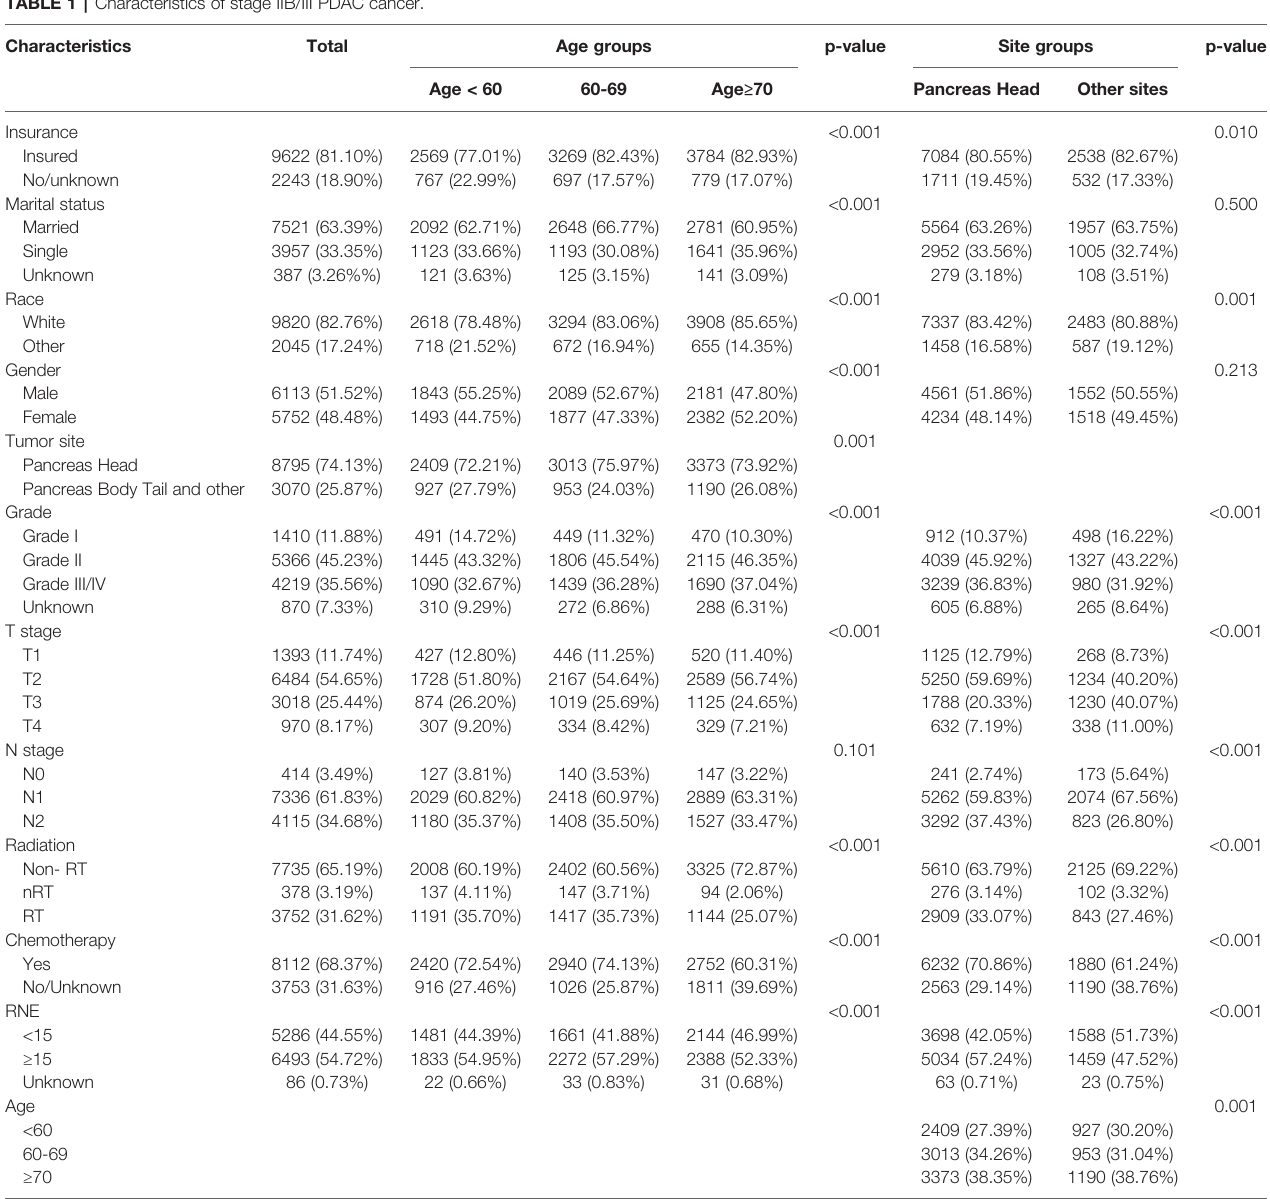
TABLE 1 | Characteristics of stage IIB/III PDAC cancer.